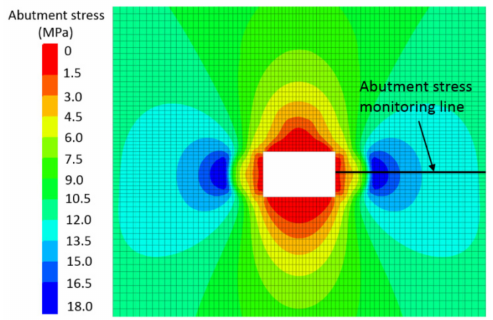
Figure 9. Abutment stress monitoring position (the roadway depth is 400